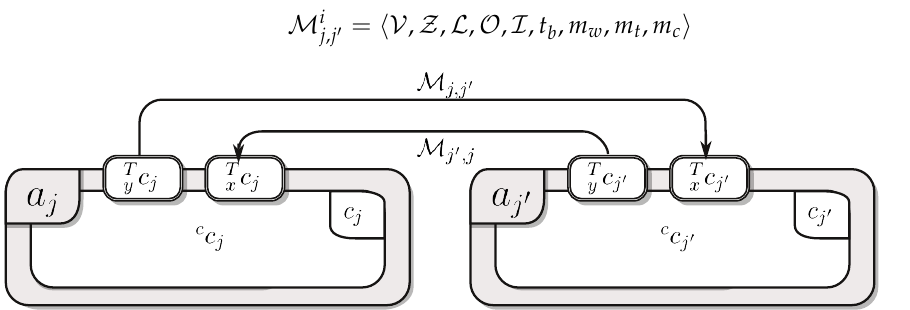
and transmitted between a j and a j M j , j (cid:48) M j (cid:48) , j